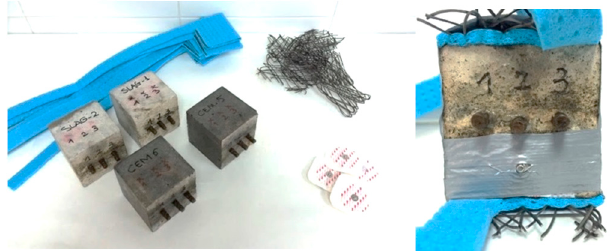
Figure 1. Specimens fabricated: steel 1 (S a ), steel 2 (S b ), and steel 3 (S c